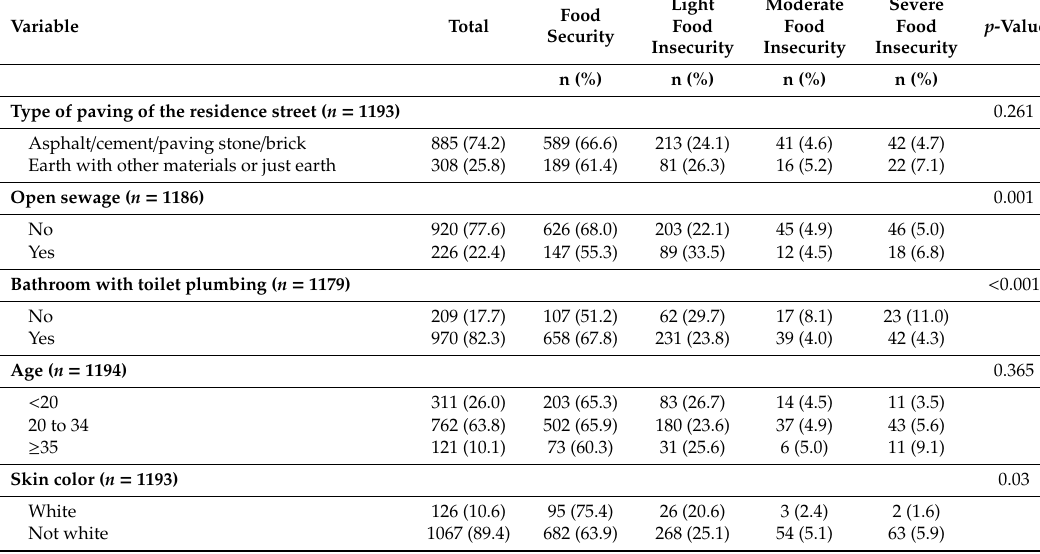
Table 1. Percentage distribution of socioeconomic, demographic, and health characteristics according to food insecurity (FI). Rio Branco, Acre,